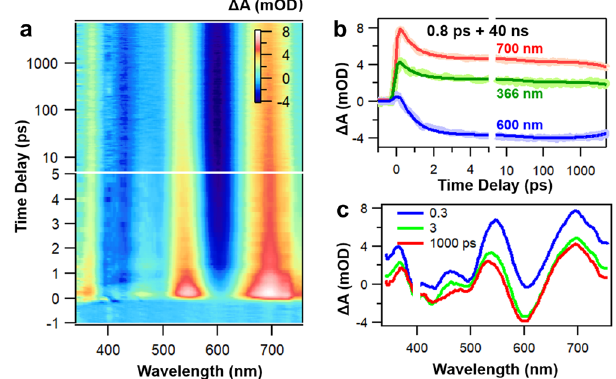
Fig. 5 Excited-state dynamics of the Au 56 NC. a TA data map of Au 56 with 400 nm excitation. b TA kinetic traces and corresponding fi ts at selected probe wavelengths. c TA spectra of Au 56 at selected time-delays.